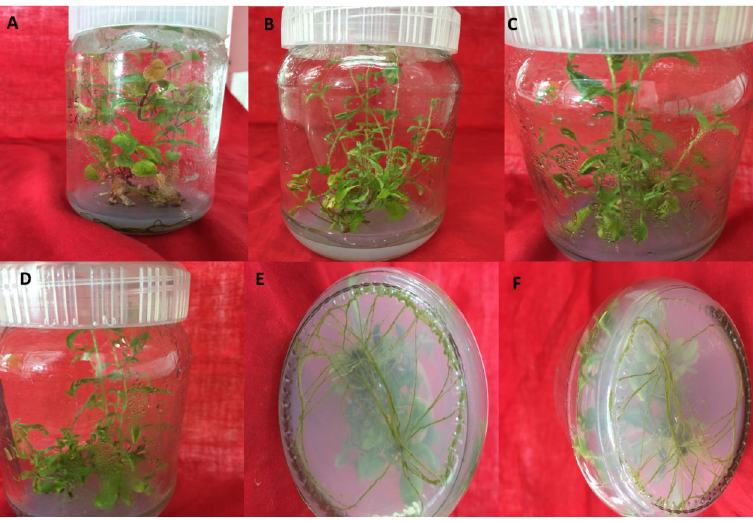
Fig 7. In vitro developed transgenic plants. A: Non-transgenic plant, B-D: Transgenic plants that are morphologically similar to non-transgenic plants. E: Roots of non-transgenic plant and F: Roots of transgenic plant.